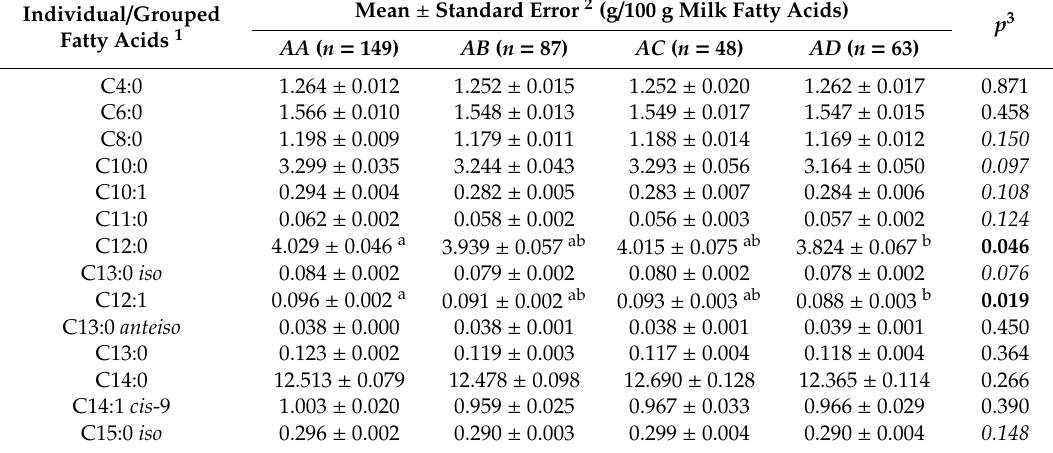
Table 1. Associations between milk fatty acid methyl ester levels and myostatin genotypes in NZ HF × J cross cows ( n = 347).